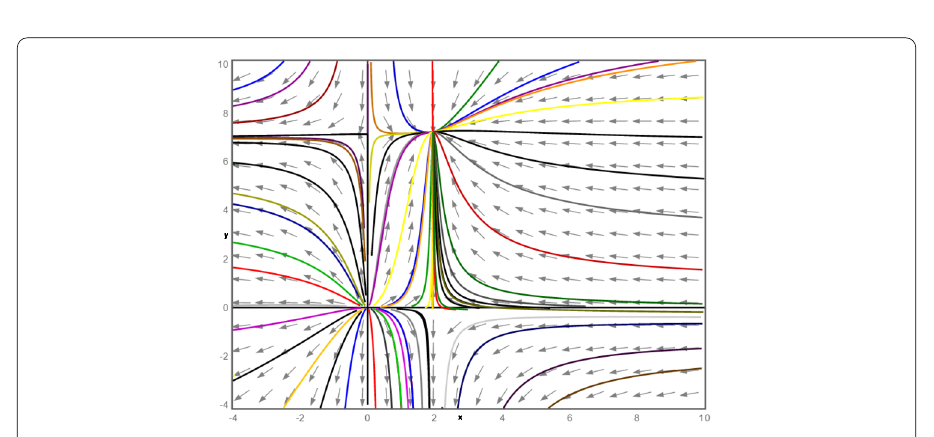
Figure 3 “Good” steady state: l 1 = 0.5, l 2 = 0